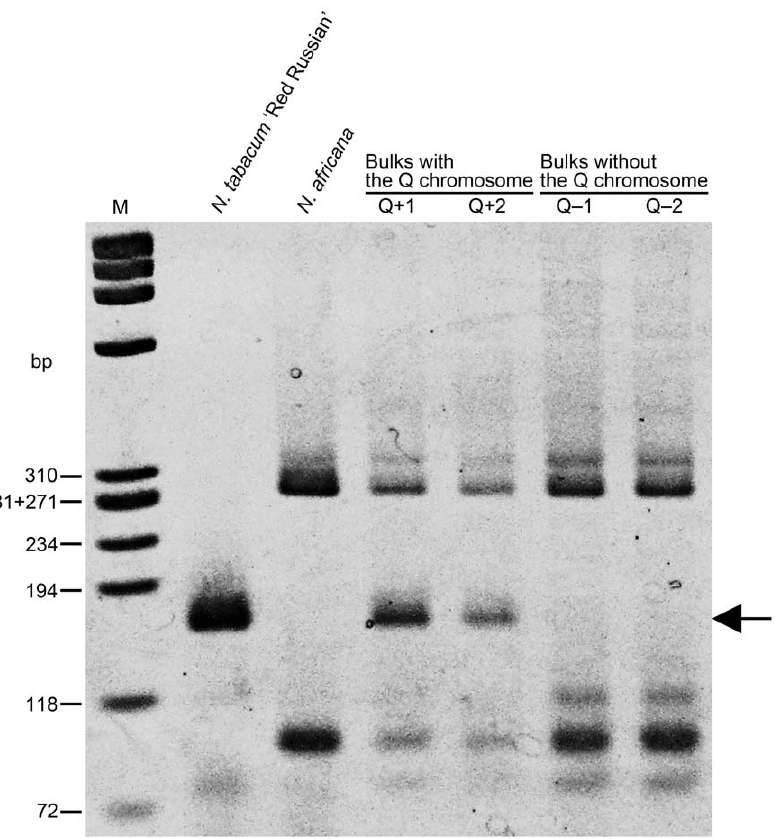
Figure 1. Detection of the SSR marker PT20383 in two types of DNA bulks. The marker band PT20383A representing the Q chromosome (Table 2) was amplified in N. tabacum ‘Red Russian’ and bulks Q + 1 and Q + 2, but not in other samples, as indicated by the arrow. M, size marker w X174/ Hae III.